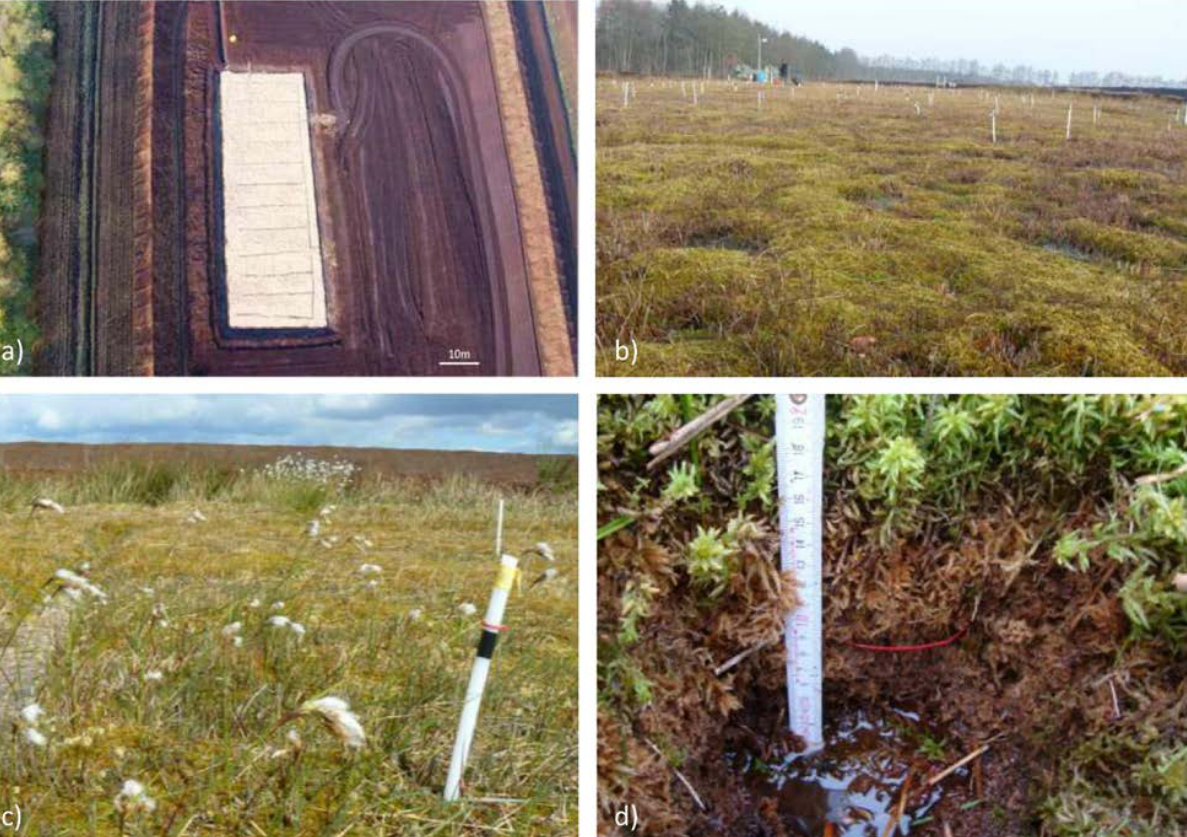
Figure 3. The Sphagnum farming study site at Ramsloh, Germany. a) Aerial view directly after installation in November 2004 within a peat cutting field; b) established Sphagnum lawn five years after installation (March 2010); c) established Sphagnum lawn with fruiting Eriophorum angustifolium and E. vaginatum (May 2010); d) Sphagnum lawn thickness six years after installation (October 2010). Photos: G.